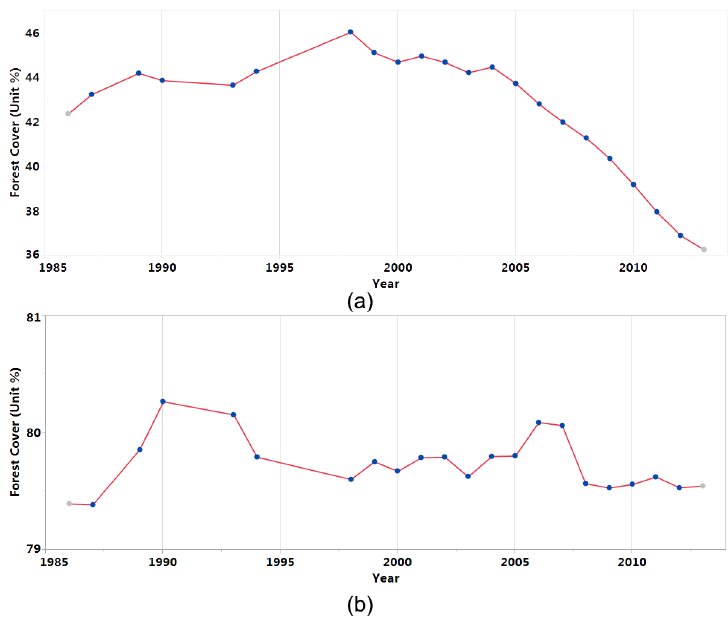
Figure 8. Forest cover dynamic for native forest area from 1987 to 2012. ( a ) Decrease; and ( b ) fluctuation.